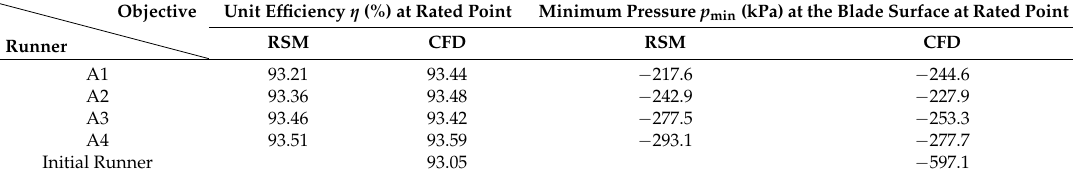
Table 5. Results in the first step optimization.